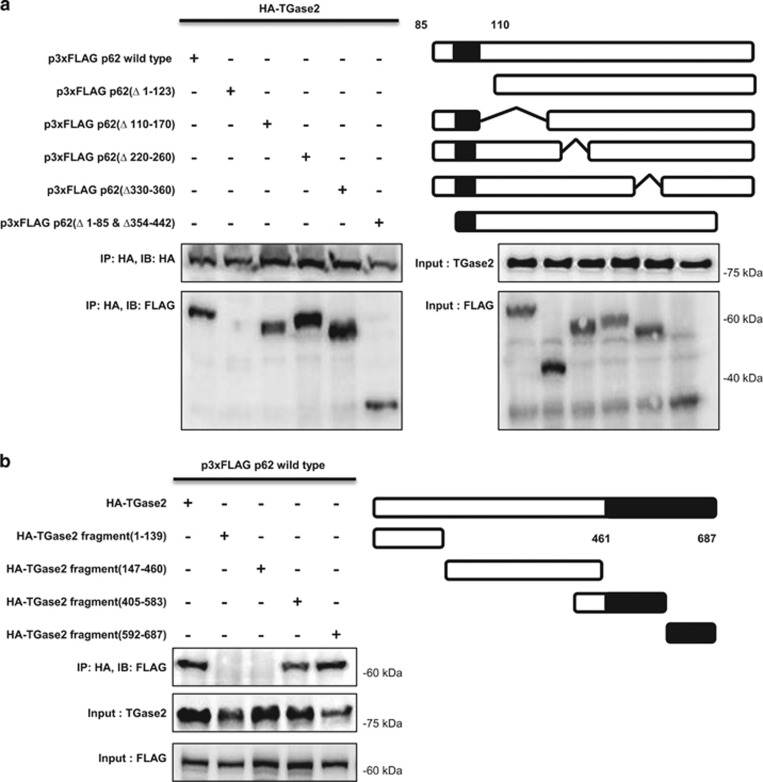
TGase 2 makes a trimer complex with p53 and p62. (a) The N terminus of p62 (residues 85–110) is the TGase 2-binding site. HEK293 cells were transfected with plasmids encoding HA-tagged TGase 2 (HA-TG2) and either wild-type p62 (p3xFLAG p62 wild type) or a p62 deletion mutant. The proteins were co-immunoprecipitated from cell extracts using an anti-HA-tag antibody and subjected to immunoblotting. (b) The C terminus of TGase 2 is the p62-binding domain (β-barrel domains, residues 461–687). HEK293 cells were transfected with p62 (p3XFLAG p62 wild type) and either wild-type TGase 2 (HA-TG2) or a TGase 2 deletion mutant. The proteins were co-immunoprecipitated from cell extracts using an anti-HA-tag antibody and subjected to immunoblotting. (c) The N terminus of TGase 2 is the p53-binding domain (residues 1–139). HEK293 cells were transfected with wild-type p53 (p3xFLAG p53) and either HA-tagged wild-type TGase 2 (HA-TG2) or a deletion mutant of TGase 2. Proteins were immunoprecipitated using an anti-HA-tag antibody. (d) Primary structures of p62, p53 and TGase 2 proteins. CRD, C-terminal regulatory domain, lysine rich domain; DBD, DNA-binding domain; KIR, Keap1-interacting region; LIR, LC3-interacting region; p53, tumor suppressor; p62, sequestosome 1; TAD, transcription-activation domain or transactivation domain; TBD, TRAF6-binding domain; TET, tetramerization domain; ZZ, zinc-finger domain